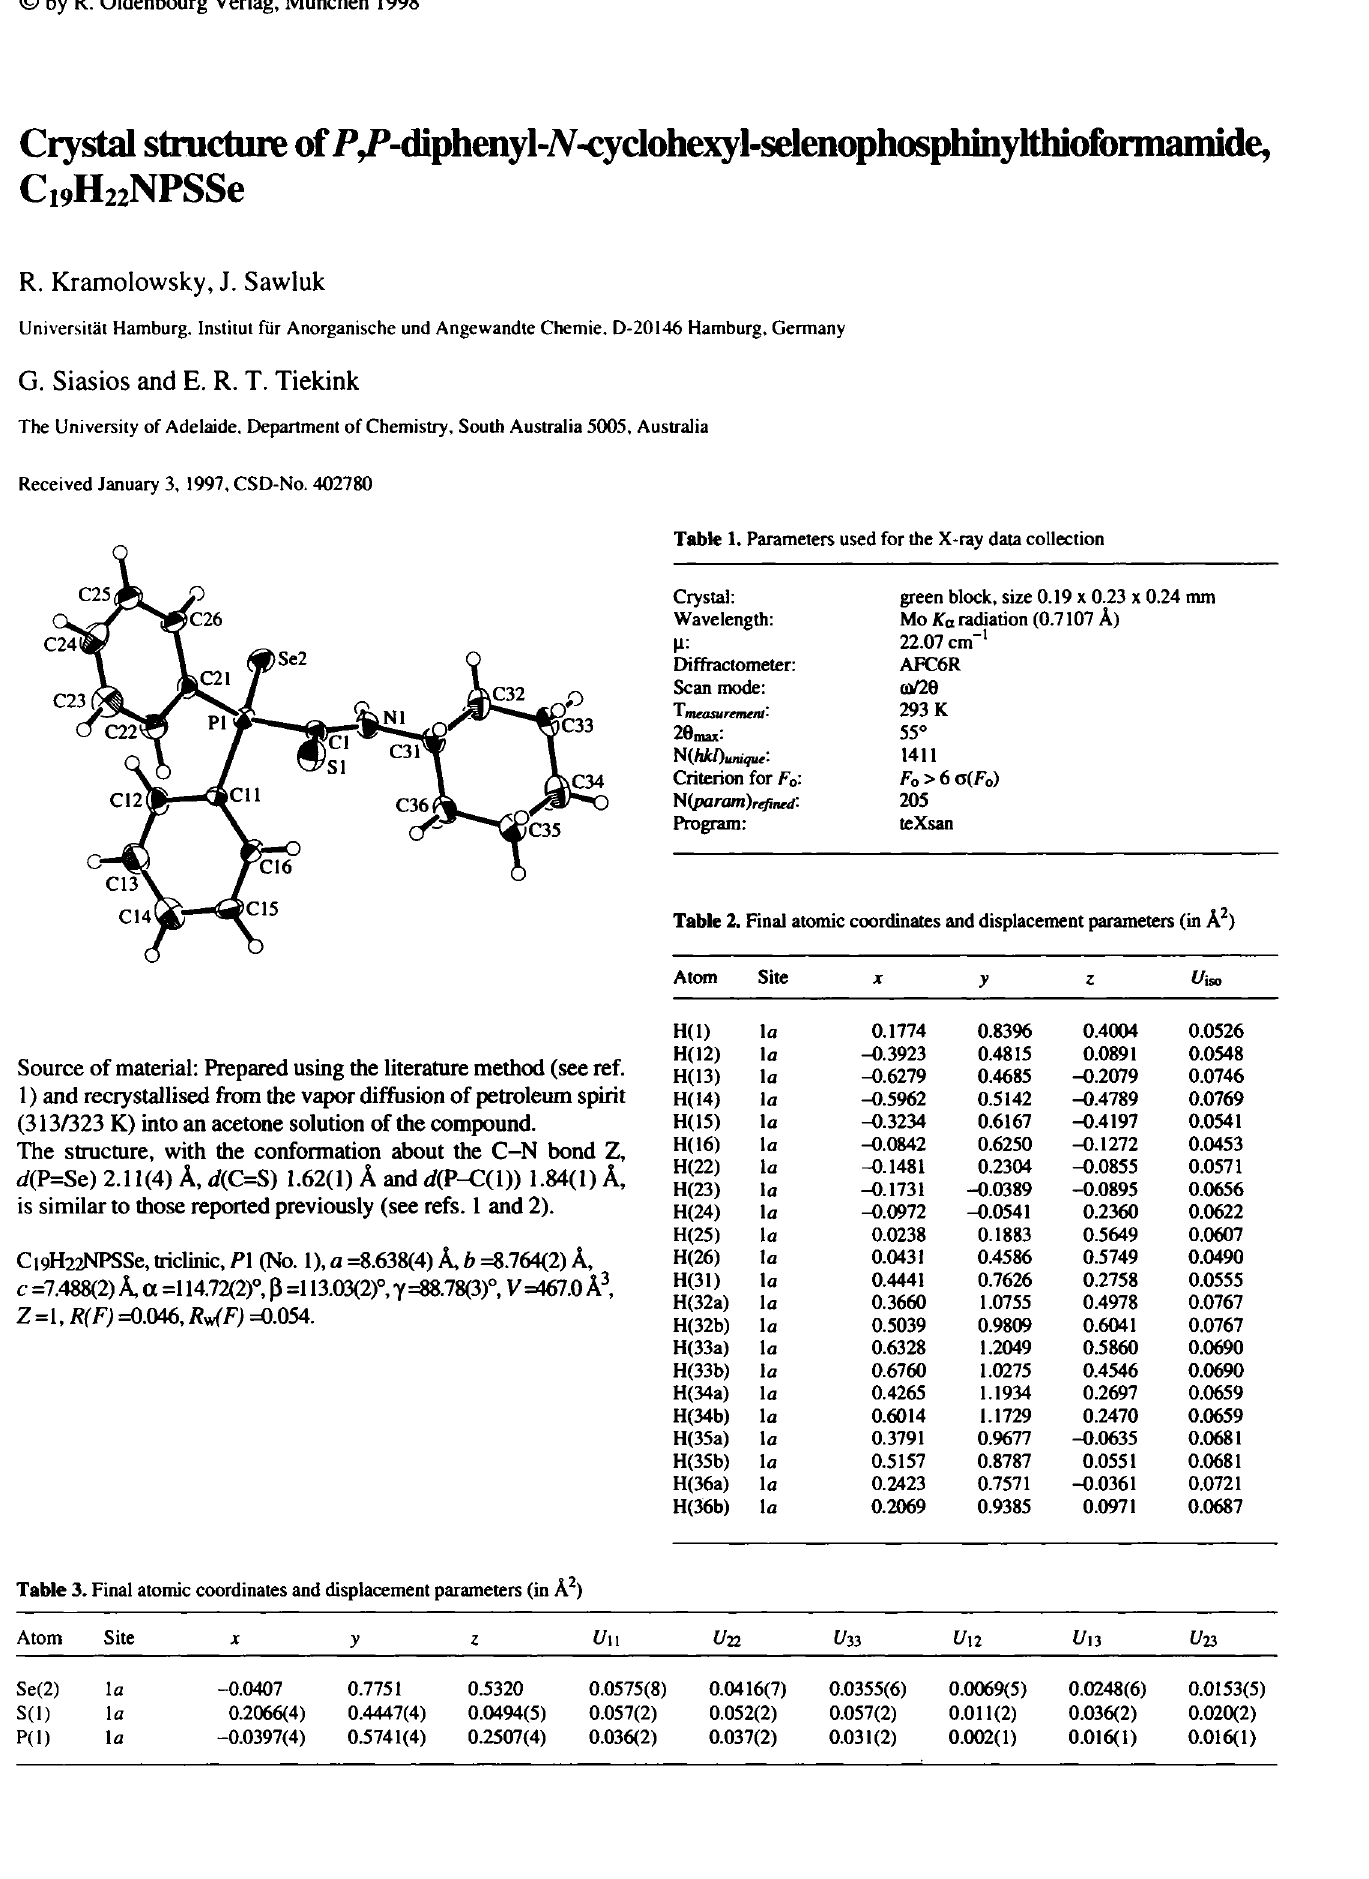
Table 1. Parameters used for the X-ray data collection Crystal: